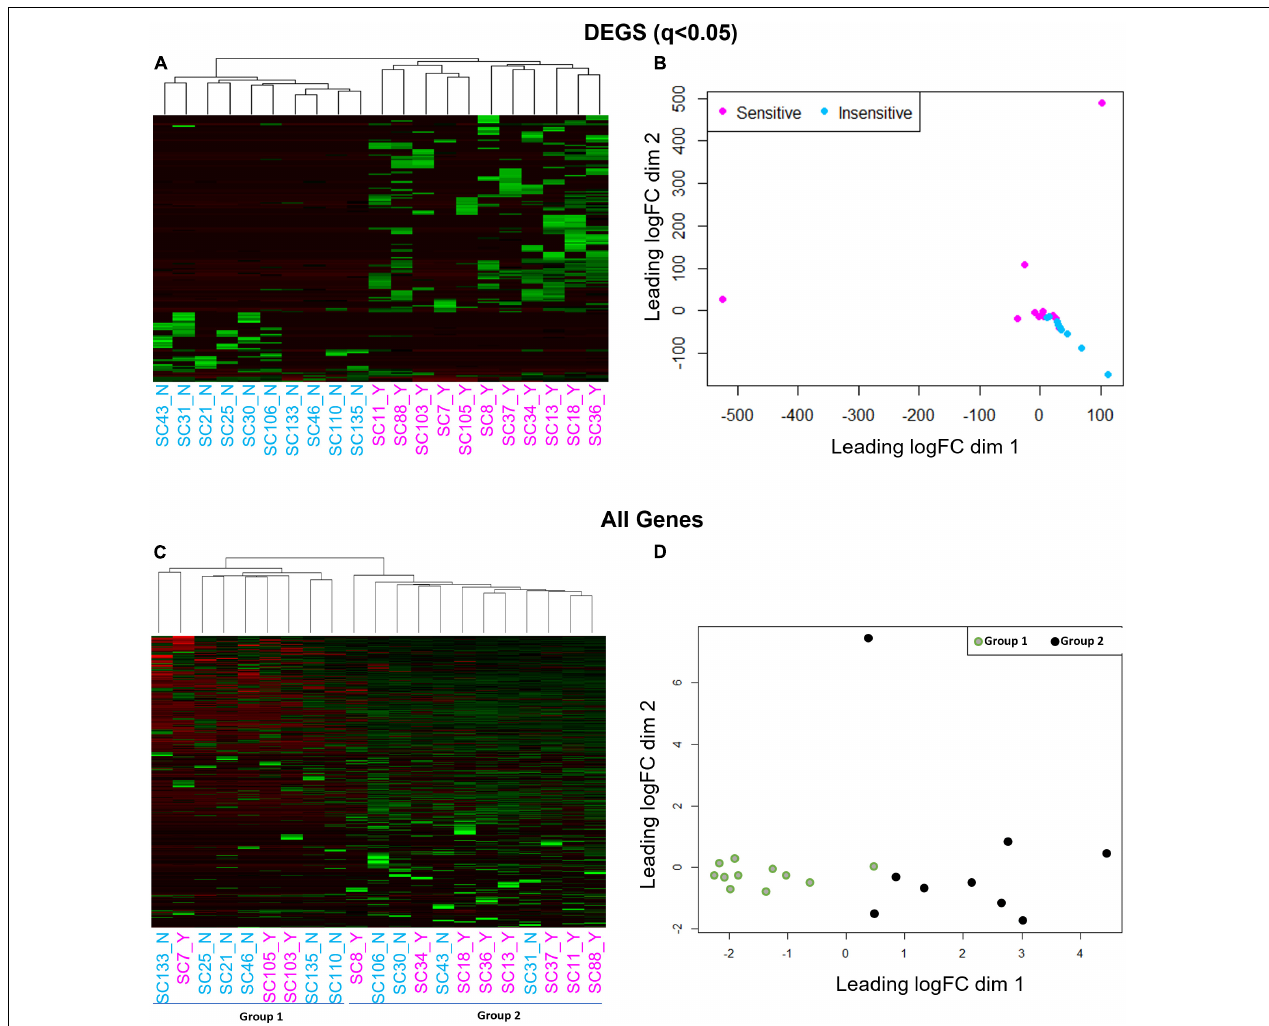
FIGURE 4 | Hierarchical clustering (A,C) and multi-dimensional scaling [MDS; (B,D) ] using all genes reveals a cell grouping unrelated to chemosensitivity versus grouping based on chemosensitivity with 166 DEGs. Hierarchical clustering and MDS using 166 DEGs result in distinct CO 2 sensitive vs. insensitive 5-HT neuron grouping by hierarchical clustering and MDS (A,B) . Hierarchical clustering and MDS using all genes measured by scRNA-Seq results in two distinct cell groups un-related to CO 2 chemosensitivity by hierarchical clustering and MDS (C,D)